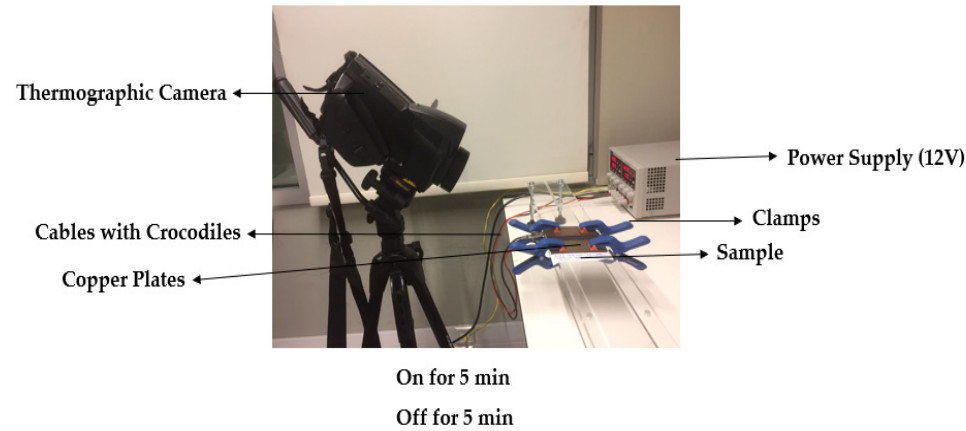
Figure 4. Setup for measuring joule heating.